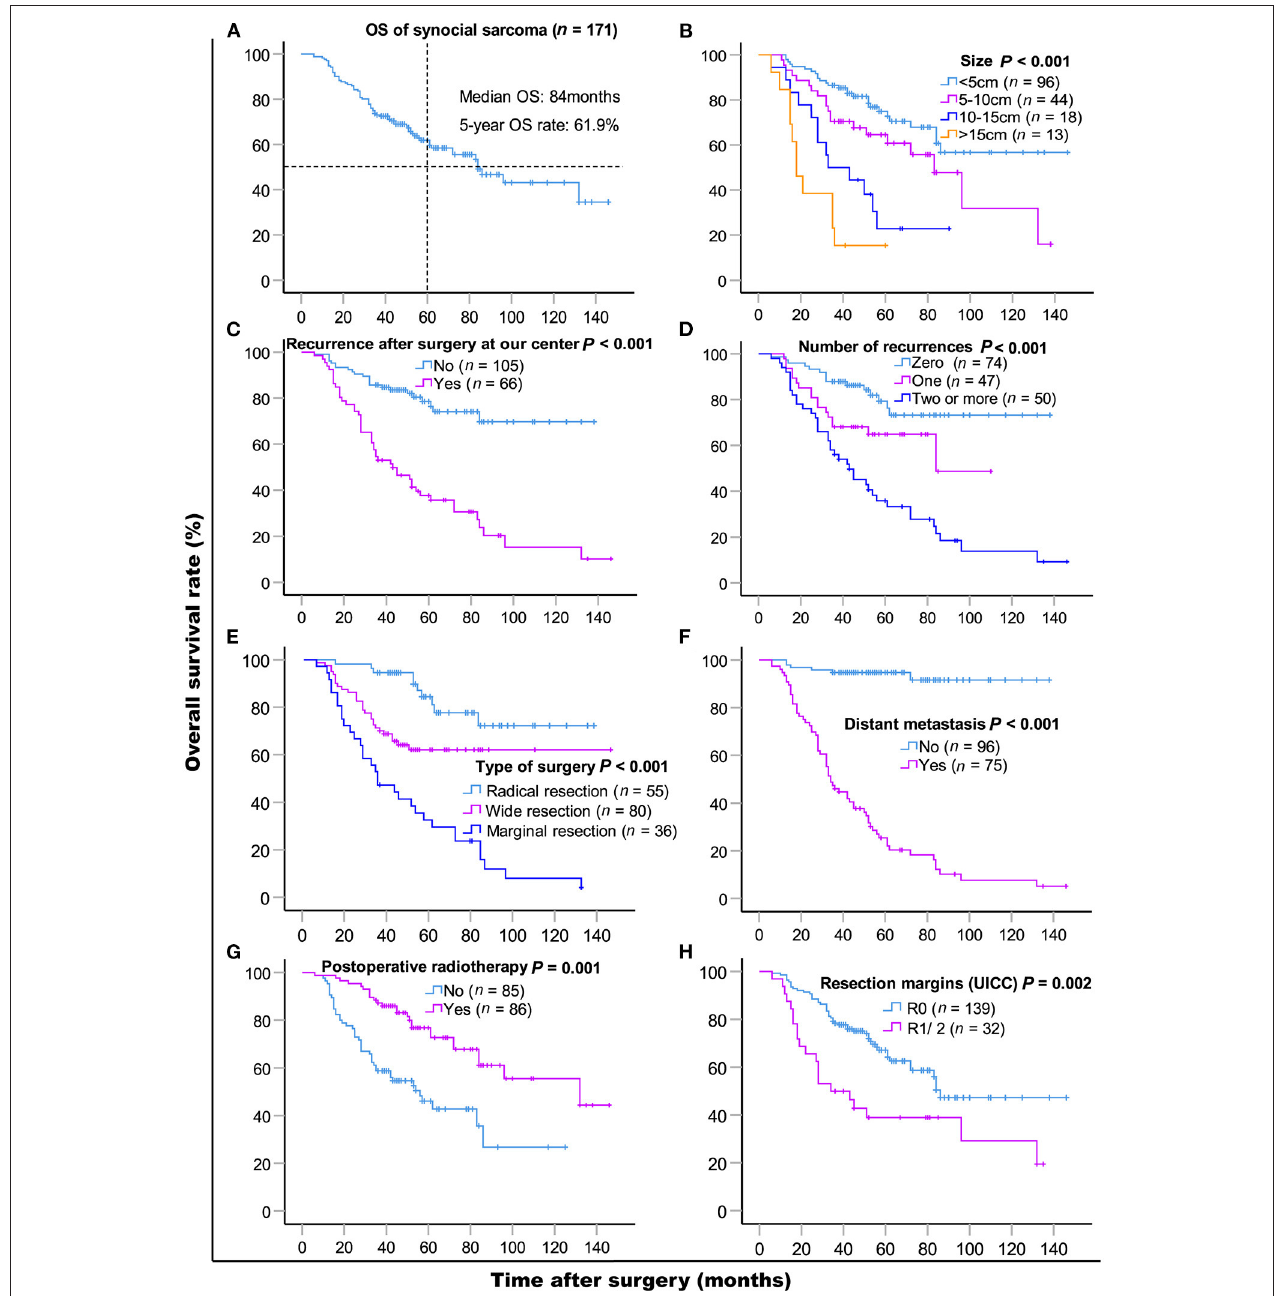
FIGURE 1 | Kaplan-Meier overall survival curves of patients with synovial sarcoma (A) and compared according to (B) tumor size, (C) recurrence after surgery at our center, (D) the number of recurrences, (E) type of surgery, (F) distant metastasis, (G) post-operative radiotherapy, (H) resection margins (UICC). Log-rank test was used to compare curves, number of patients in subgroup ( n ) and significance ( P ) are shown on panels. was abandoned those who received palliative chemotherapy only median OS of the early and late recurrence groups being 18 and were 6 and 10 months, respectively ( P = 61 months, respectively ( P < 0.001). Among the 66 patients with LR, 27 (27/66, 40.9%) were repeatedly treated with surgery and had a median survival of 54 months after recurrence. The 5-year OS rates of the patients with or without DM were 94.7 and 25.4%, respectively ( P < 0.001). In patients with advanced metastatic SS, the median survival times of patients for whom treatment